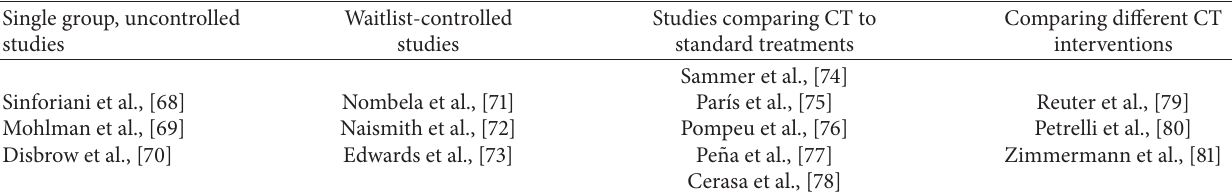
Table 1: Classification of studies of CT in PD according to